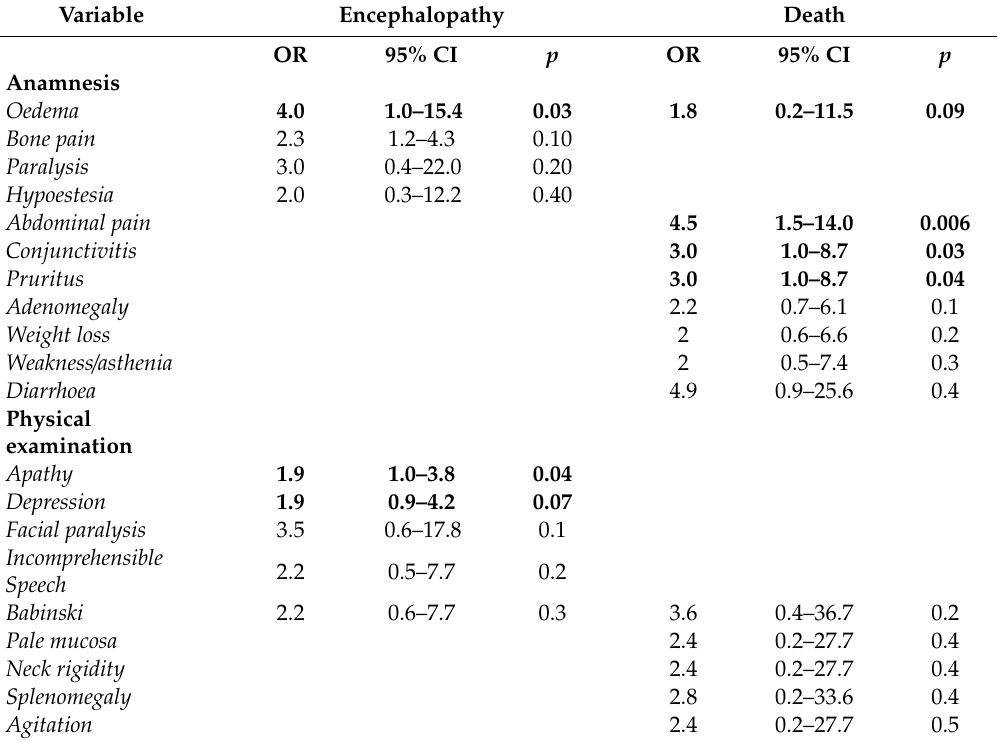
Table 4. Anamnesis, physical examination, and laboratory variables obtained during admission and corresponding statistical tests for association with the development of ES or death from